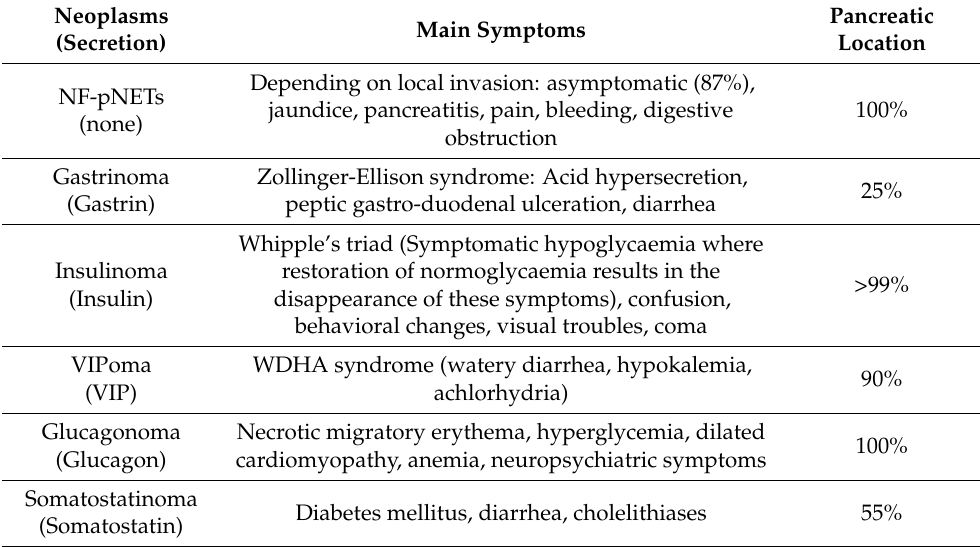
Table 1. Clinical characteristics of pNETs [3–5].